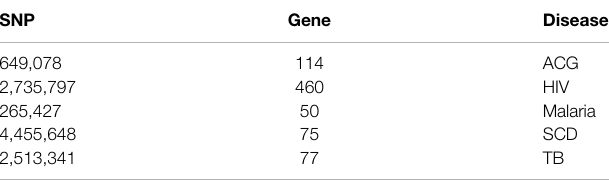
TABLE 1 | Number of SNPs after quality control (QC) in each group of genes associated with HIV, TB, SCD, malaria, and actionable genes.